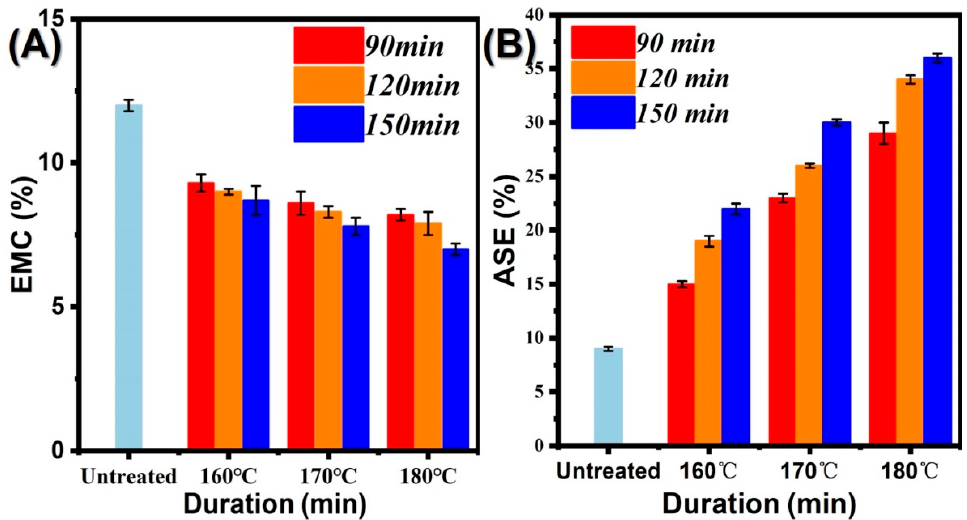
Figure 6. ( A ) EMC; ( B ) ASE of bamboo